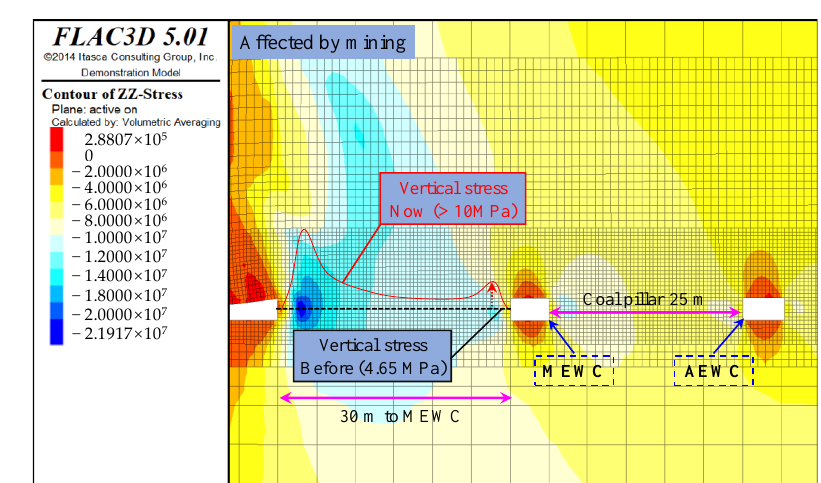
Figure 11. Law of stress evolution during final mining.